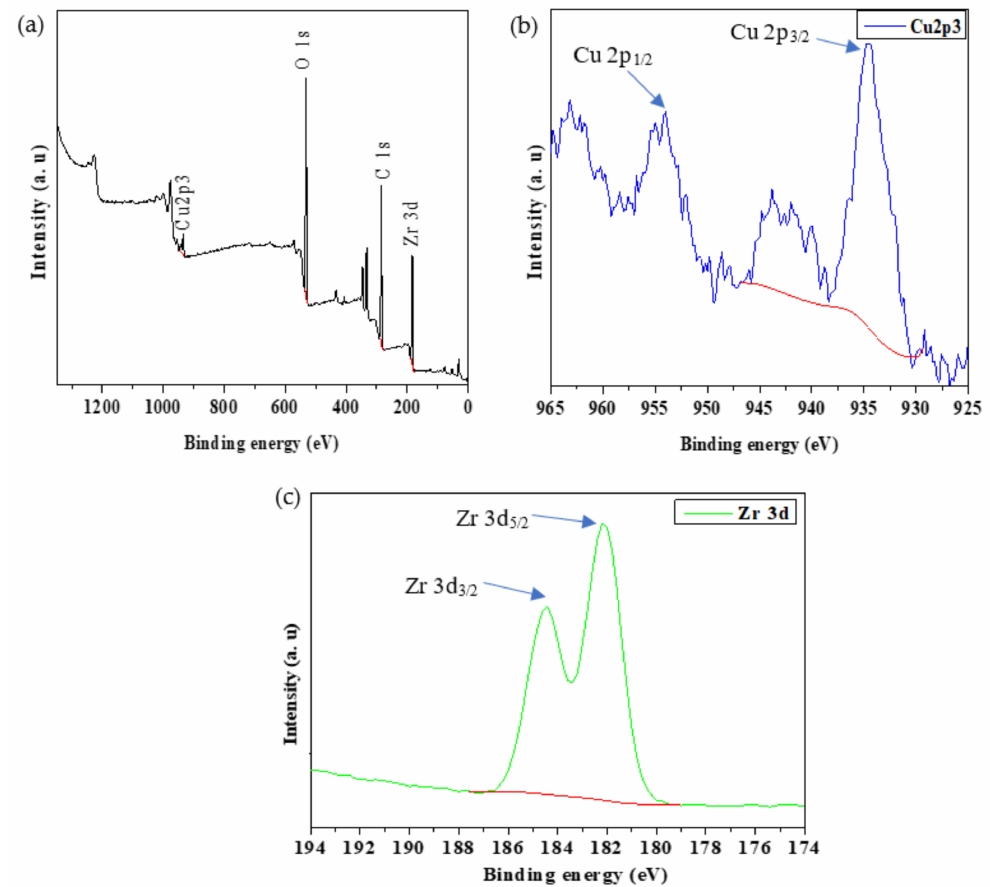
Figure 4. XPS spectra of ( a ) Cu/ZnO/UiO-66 full survey, ( b ) Cu2p3, and ( c )